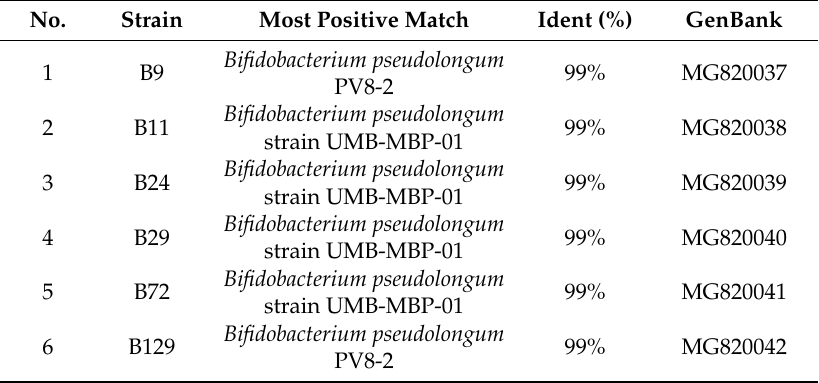
Table 4. The identified strains isolated from mice